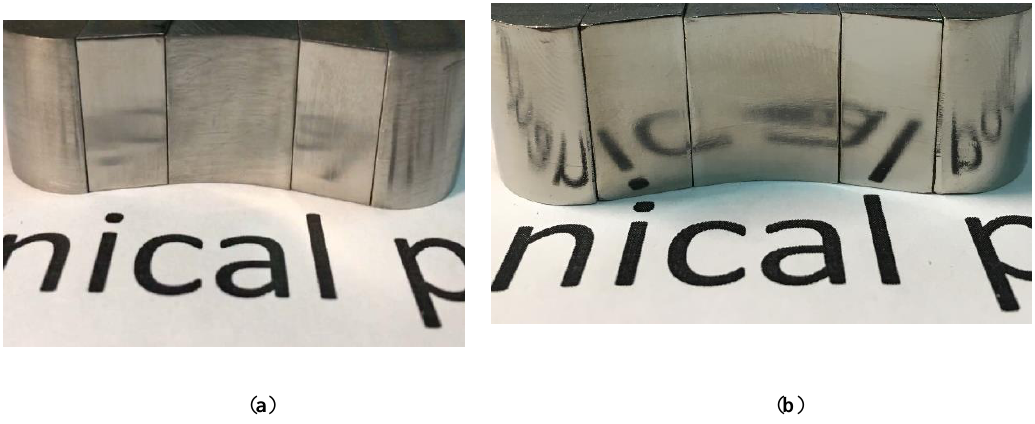
Figure 20. Workpiece surface: ( a ) original workpiece; and ( b ) finished workpiece.